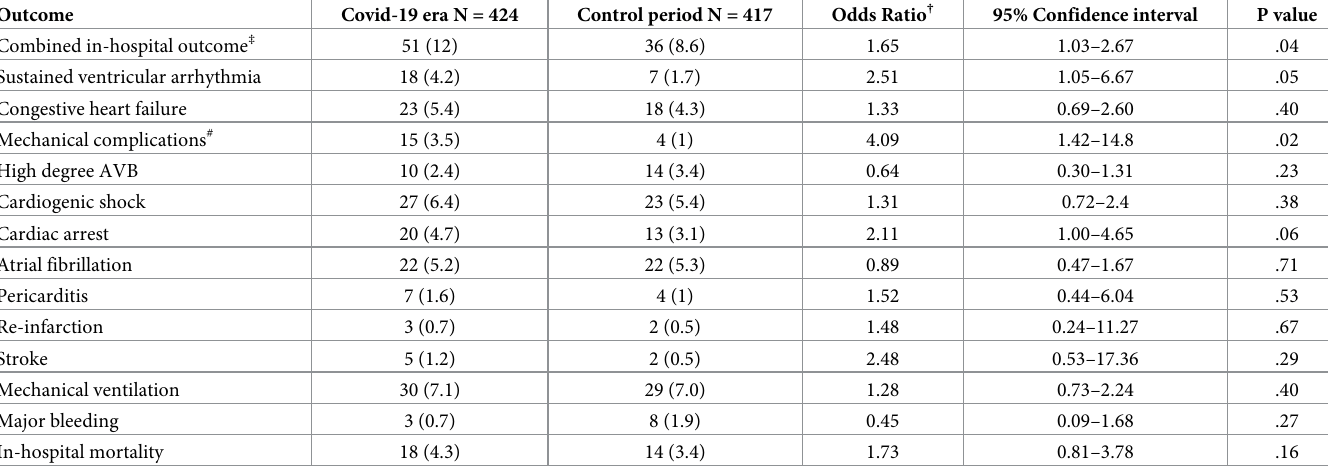
Table 3. Multivariable � logistic regression model for in-hospital outcomes of STEMI patients during the Covid-19 pandemic.